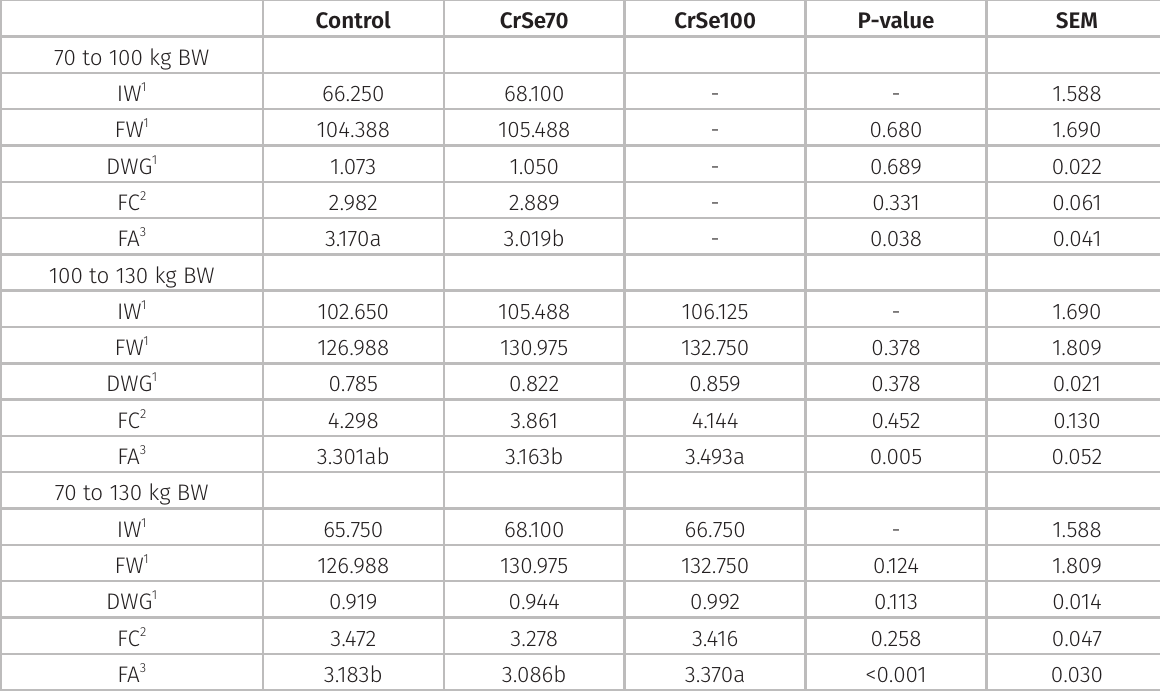
Table II. Performance of swine supplemented with organic chromium and selenium from 70 to 130 kg body weight. Control